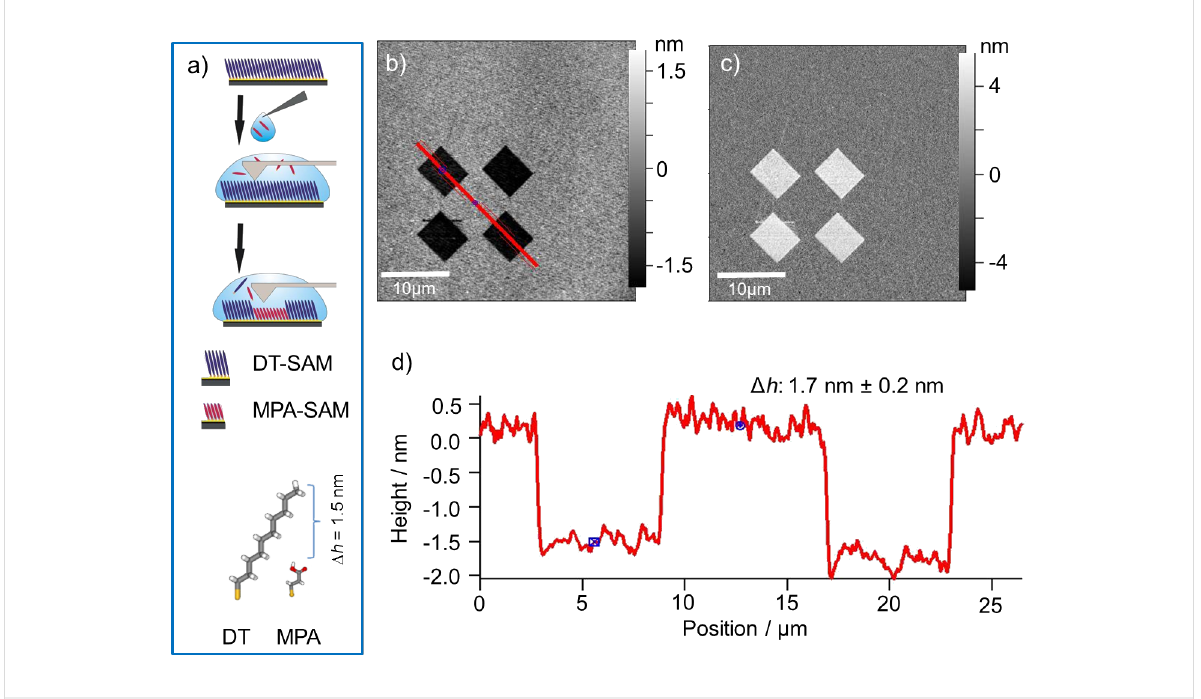
Figure 3: (a) Scheme of the grafting experiment and used SAM molecules (without H-atoms). AFM-topography (b) and -phase (c) image of MPA structures grafted in a DT SAM matrix. (d) Cross section along the red line in (b).